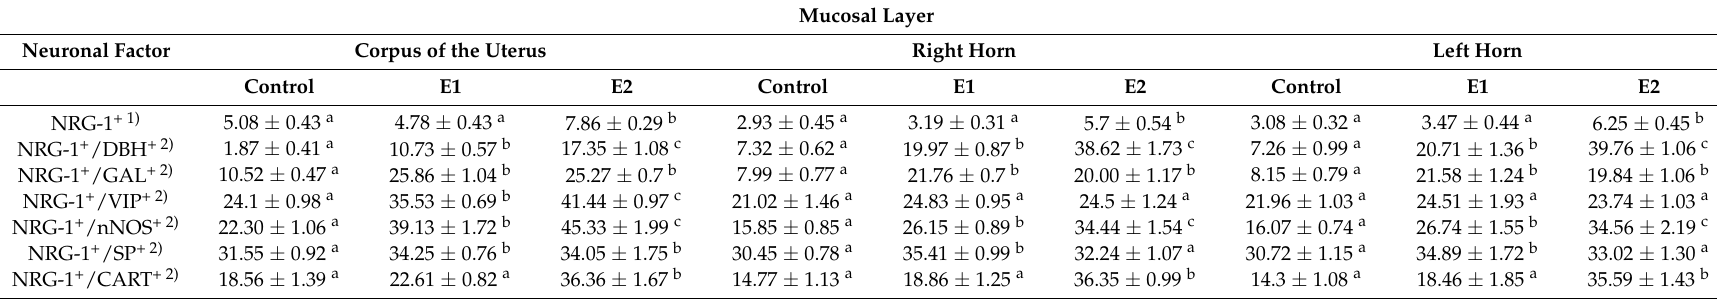
Table 2. The number of Neuregulin-1-positive fibers and their neurochemical characterization in the uterine mucosal layer of the control animals (Control) and pigs treated with low (E1) and high (E2) doses of bisphenol